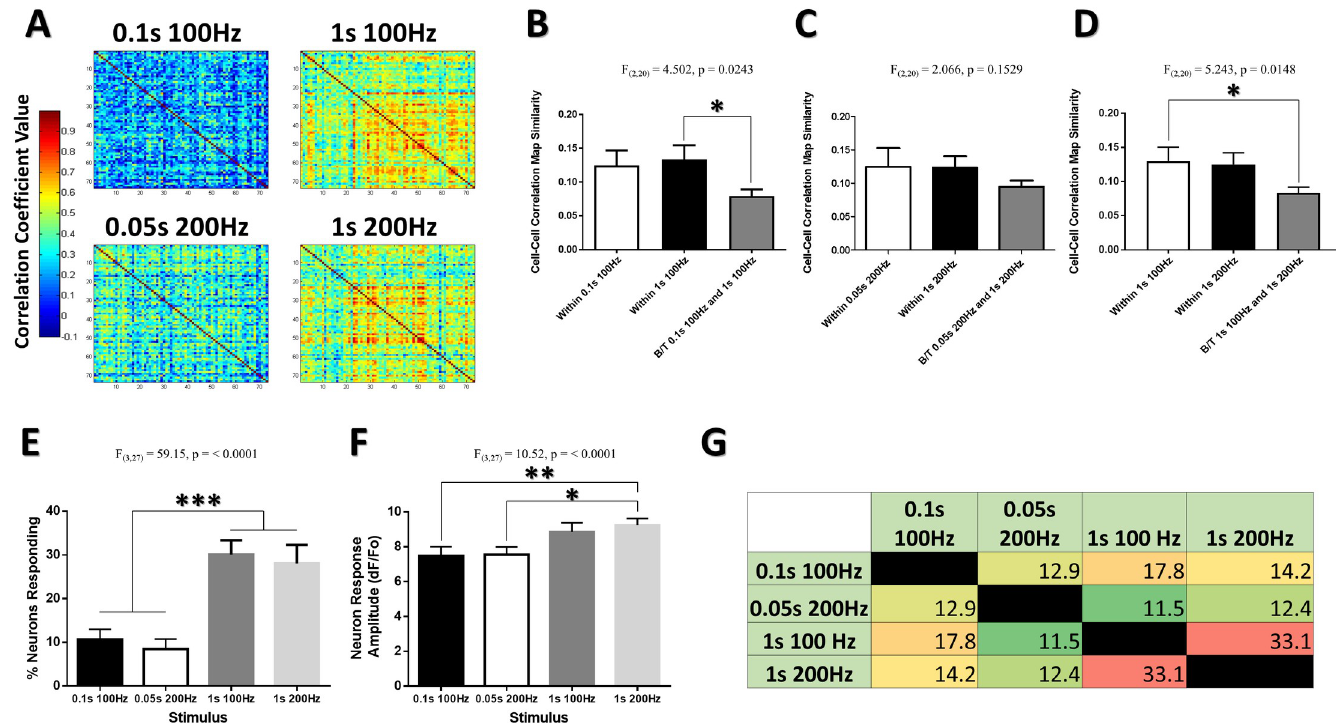
Fig 6. Longer stimuli evoke more consistent patterns of activity in somatosensory neuronal networks. ( A ) Example heat map matrices of the pairwise stimulus- evoked correlation coefficient between a population of 74 neurons within the cFL somatosensory cortex of one example animal at 160 μ m depth for 100 and 200Hz stimuli of different durations. Structural similarity comparison of the maps for all trials depicts greater map similarity for within stimulus conditions than between stimulus for 0.1s 100Hz and 1s 100Hz comparisons ( B ), and a trend for 0.5s 200Hz and 1s 200Hz comparisons ( C ). Significantly less map similarity is seen between 1s 100Hz and 1s 200Hz comparisons than for within stimulus comparisons ( D ). A significant effect of stimulus duration is observed in the percent of neurons responding ( E ) and in the neuron response amplitude ( F ). ( G ) Color coded quantification chart displaying the percentage overlap between neuron populations responsive to each stimulus quantified for all animals (N = 10). � p < 0.05; �� p < 0.01; ��� p <